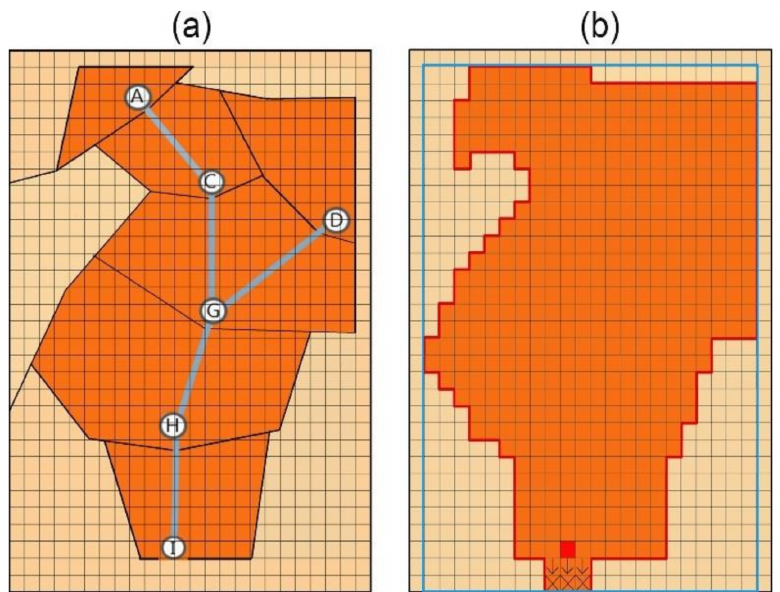
Figure 5. ( a ) The intersection between sub-impact zones and the high-resolution DEM’s grids. ( b ) The computational domain determination for MIKE FLOOD’s 2D simulation, where dark orange grid- cells represents critical computational cells configuring the reduced computational domain, the blue frame represents the reduced rectangular modelling grid extent and the red frame represents the reduced computational domain and the optimised boundary conditions. The red grid-cell represents the location of terminal pour points, and the grid-cells marked ↓ configure the 2D weir having the spilling elevation level. Furthermore, the grid-cells marked × configure retention volumes based on decreased